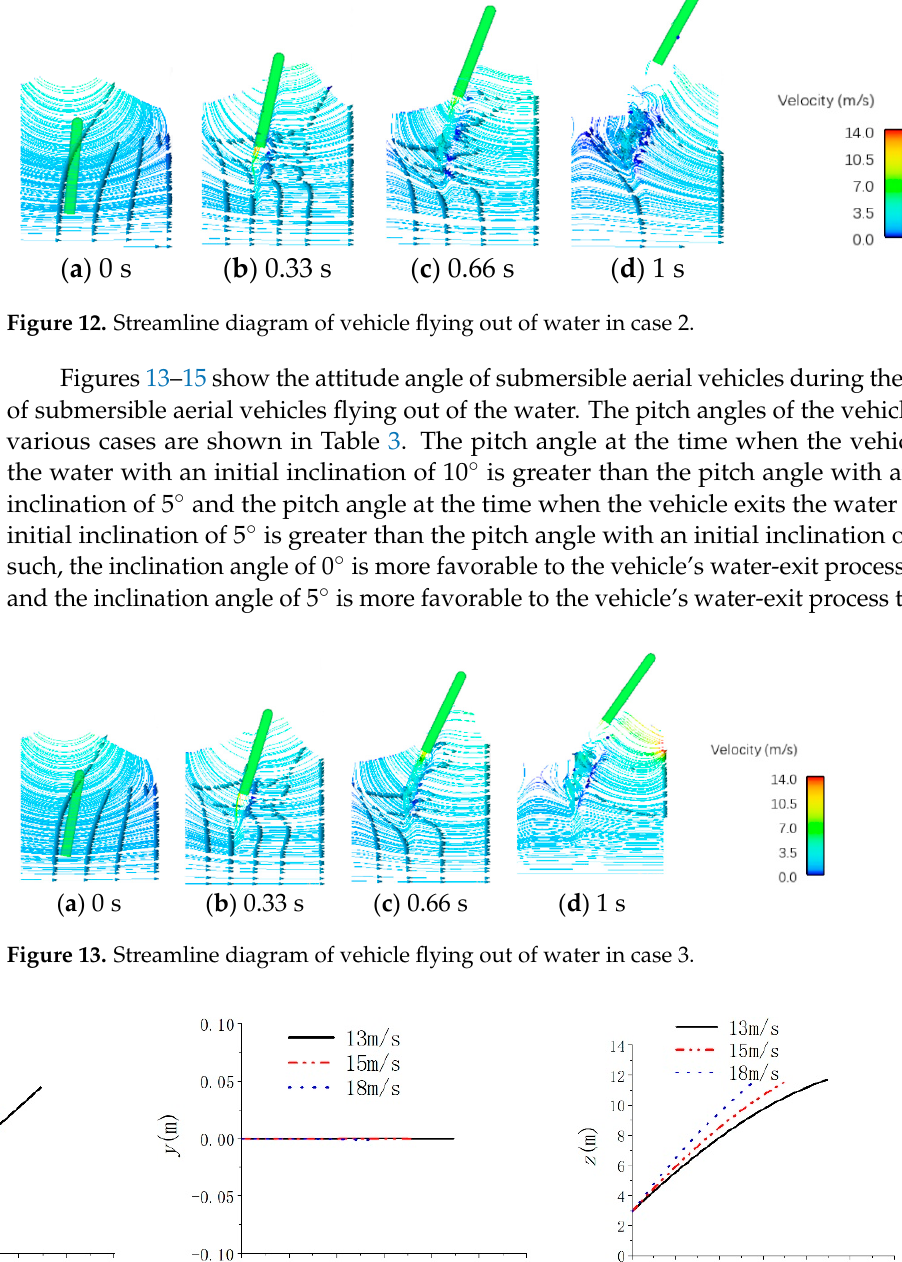
Figure 14. Centroid coordinates of vehicle in case 1, 4, 7. ( a ) Vehicle centroid X -axis coordinates. ( b ) Vehicle centroid Y -axis coordinates. ( c ) Vehicle centroid Z -axis coordinates.